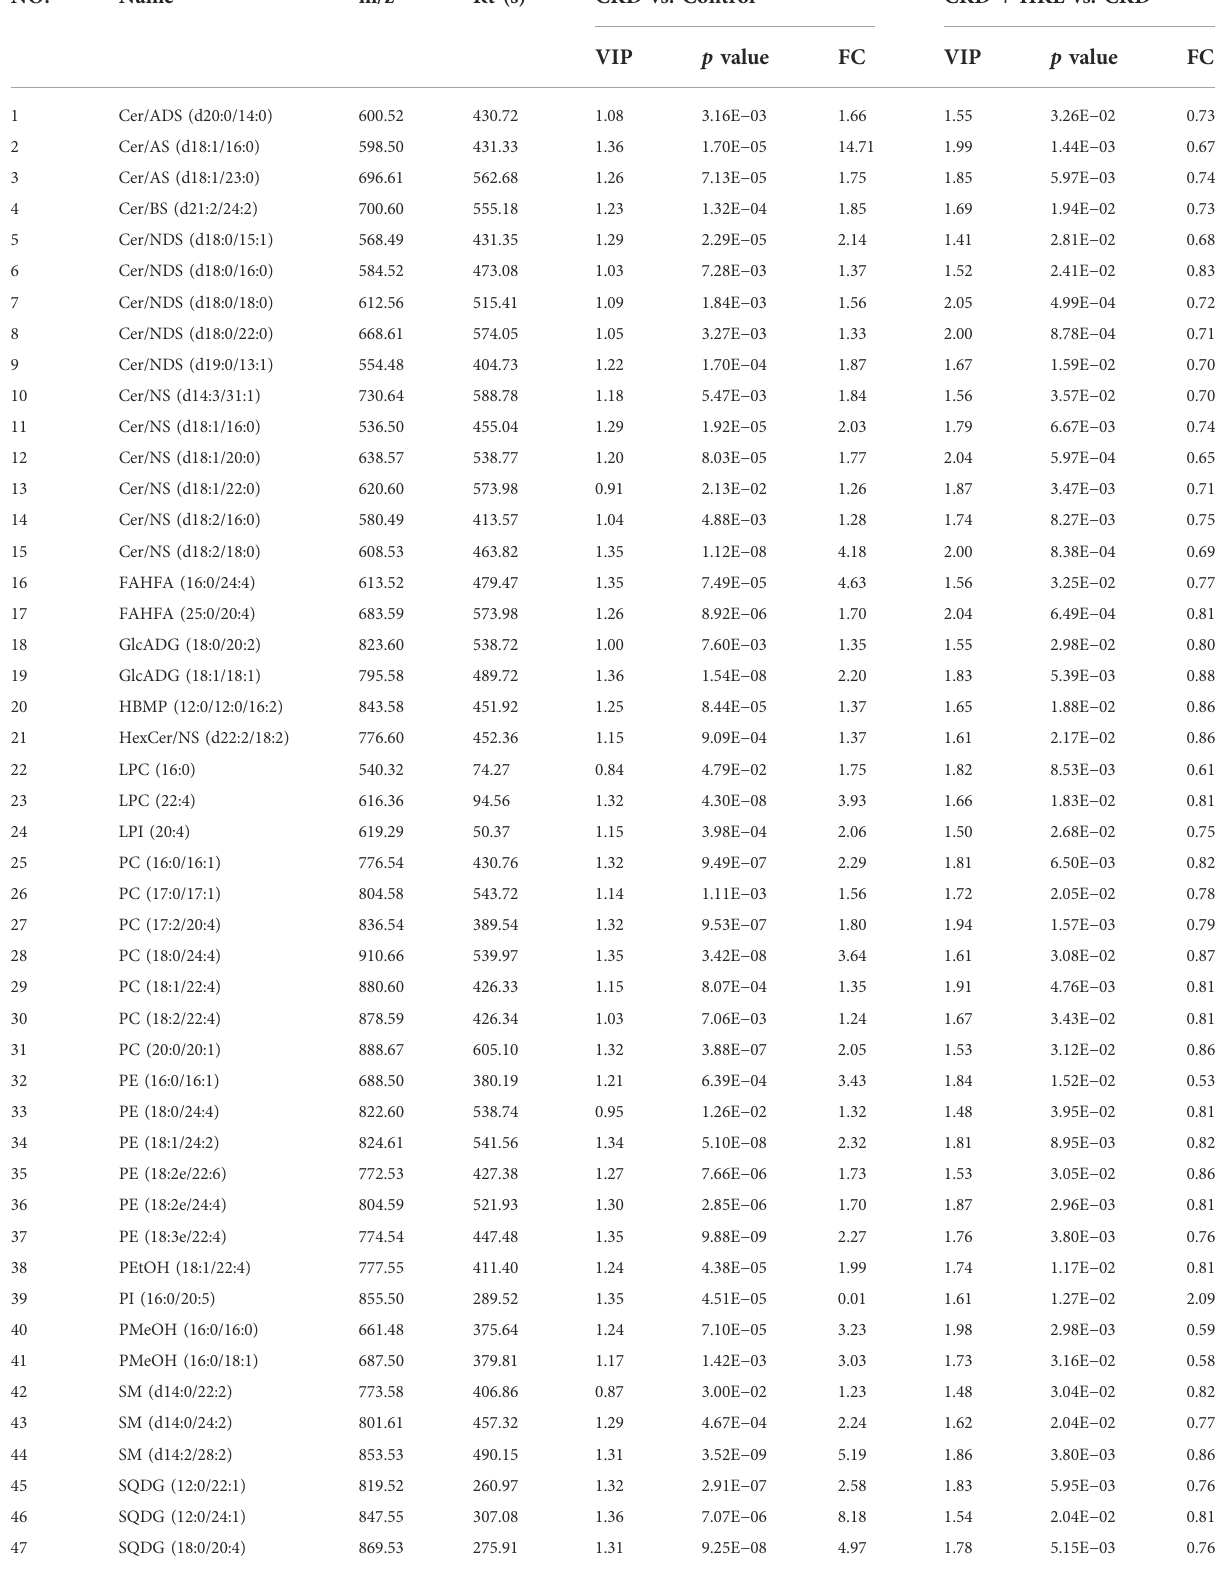
TABLE 1 The information of 47 identi fi ed lipids reversed by HKL treatment in negative ion mode.